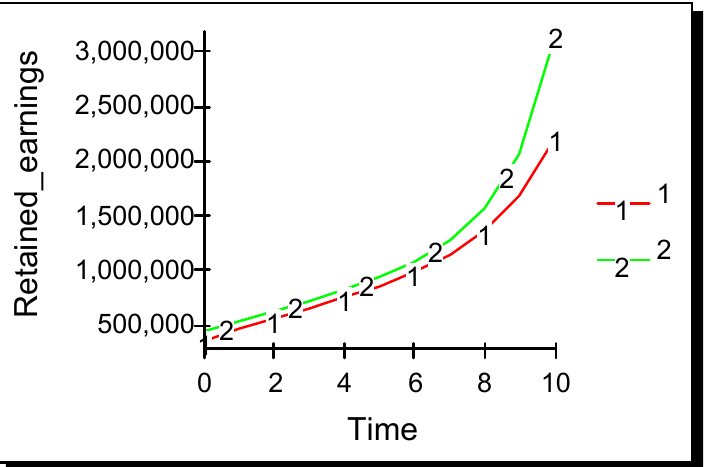
Figure 10. Unilateral perfectly cooperative advertising. Advertising effectiveness: φ 1 = 0.000022; φ 2 = 0; advertising interaction: ρ = 1.